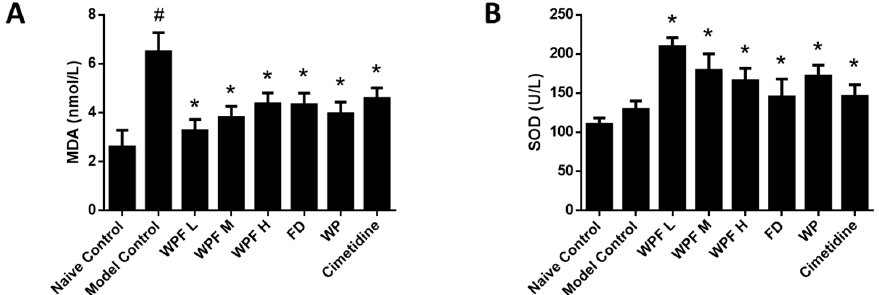
Figure 3. Anti-oxidant effect of WPF. Serum levels of malondialdehyde (MDA) ( A ) and superoxide dismutase (SOD) ( B ) were determined by using commercially available colorimetric kits. Data are presented as mean ± SD. N = 10. # p < 0.05 vs. naïve control, * p < 0.05 vs. model control. WPF L: Low dose of WPF; WPF M: Medium dose of WPF; WPF H: High dose of WPF; FD: Fucoidan; WP: Wheat peptides.